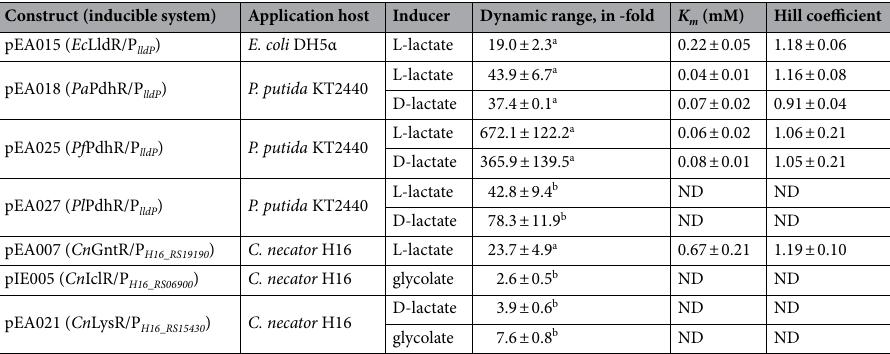
Table 1. Parameters of the lactate-inducible systems. Data are mean ± SD, n = 3. ND-not determined. a calculated according to Methods section, formula (3). b calculated by dividing the maximum level of fluorescence output by the basal level of fluorescence